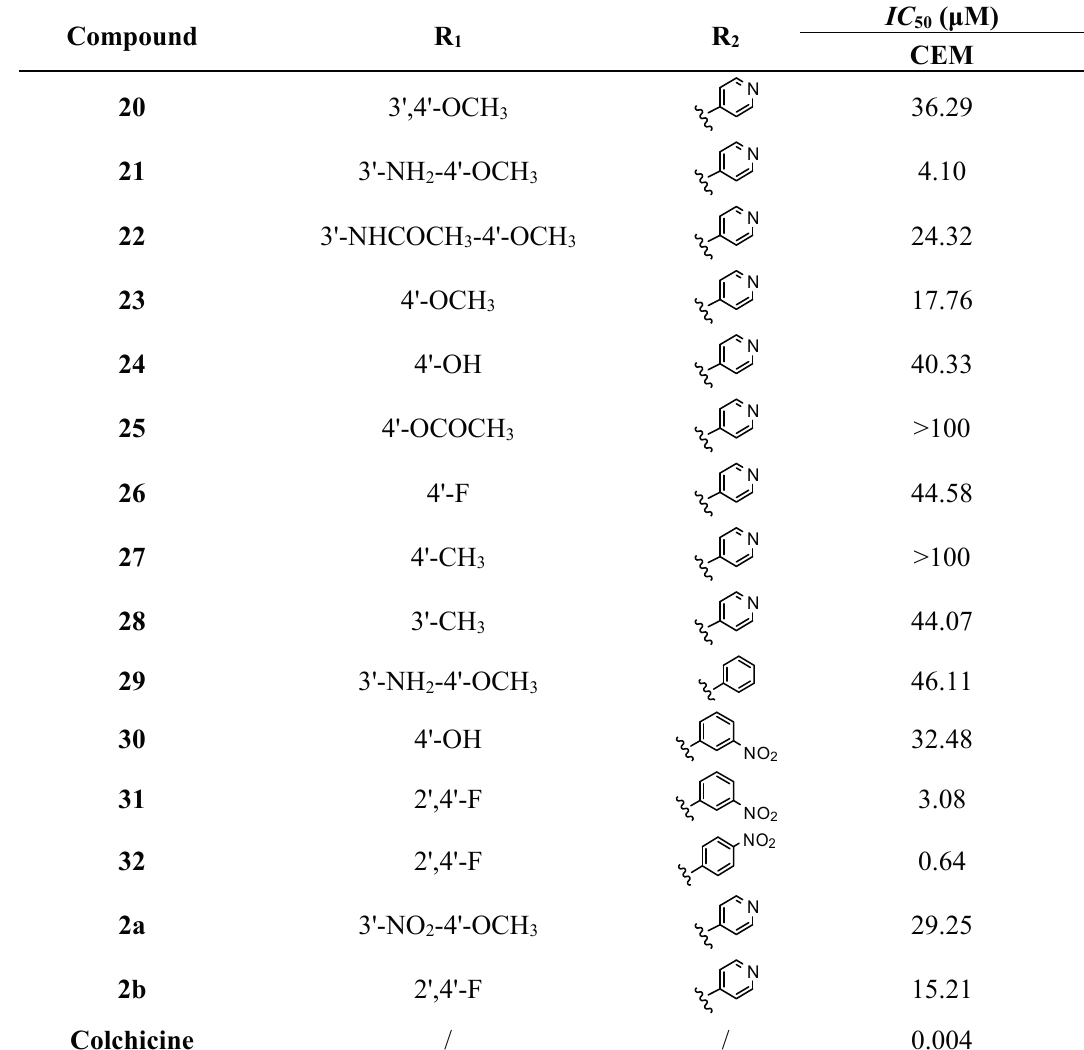
Table 1. Cytotoxic activities of the target